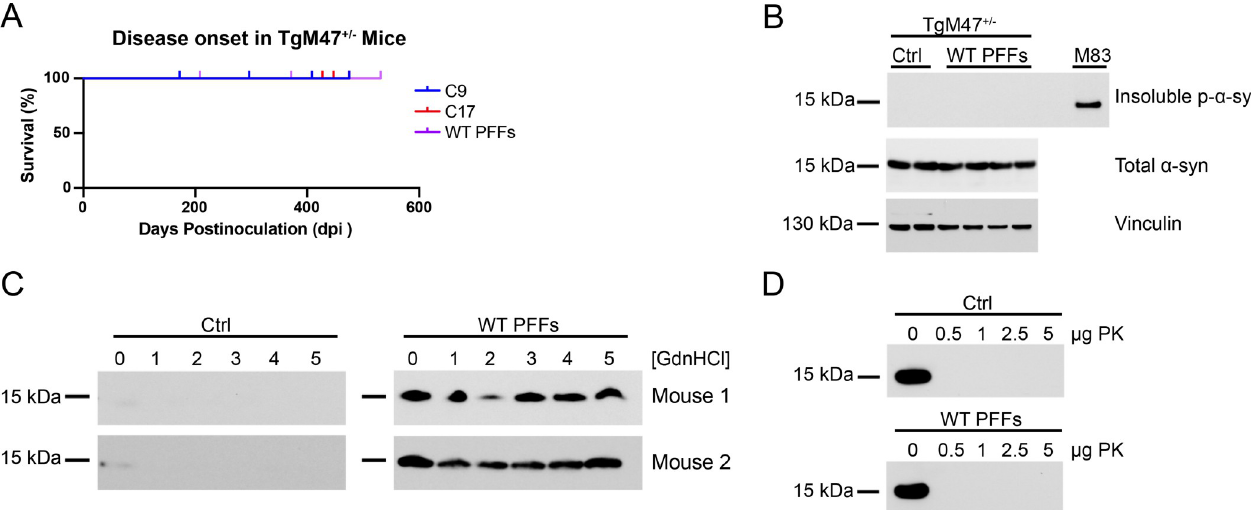
Fig 4. TgM47 +/- mice propagate WT α -synuclein PFFs. Eight-week-old TgM47 +/- mice were inoculated with 30 μ g of WT human α -synuclein PFFs or 30 μ L of 1% brain homogenate from control patient samples. (A) Kaplan-Meier plot shows mice inoculated with WT PFFs did not develop neurological disease 531 days postinoculation (dpi; P > 0.05). (B) Two brain homogenates from TgM47 +/- mice inoculated with control patient samples and four homogenates from mice inoculated with WT PFFs were assayed for the presence of insoluble α -synuclein following detergent extraction. An MSA-inoculated TgM83 +/- mouse brain, which we have previously shown is positive for phosphorylated α -synuclein, was included as a positive control (EP1536Y primary antibody). None of the samples from inoculated TgM47 +/- mice contained aggregated α -synuclein, though total α -synuclein levels (MJFR1 primary antibody) were consistent across all mice tested. Vinculin shown as a loading control. (C) Guanidine hydrochloride (GdnHCl) denaturation was performed using brain homogenates from two control-inoculated (left) and two WT PFF–inoculated TgM47 +/- mice (right) using 0, 1, 2, 3, 4, and 5 M GdnHCl. After detergent extraction, α -synuclein in the resulting protein pellet was detected via Western blot with the total α -synuclein antibody MJFR1. (D) Proteinase K (PK) digestion was performed using brain homogenates from one control-inoculated (top) and one WT PFF–inoculated TgM47 +/- mouse (bottom) using 0, 0.5, 1, 2.5, and 5 μ g PK. After detergent extraction, total α -synuclein in the resulting protein pellets was detected via Western blot with the antibody MJFR1.